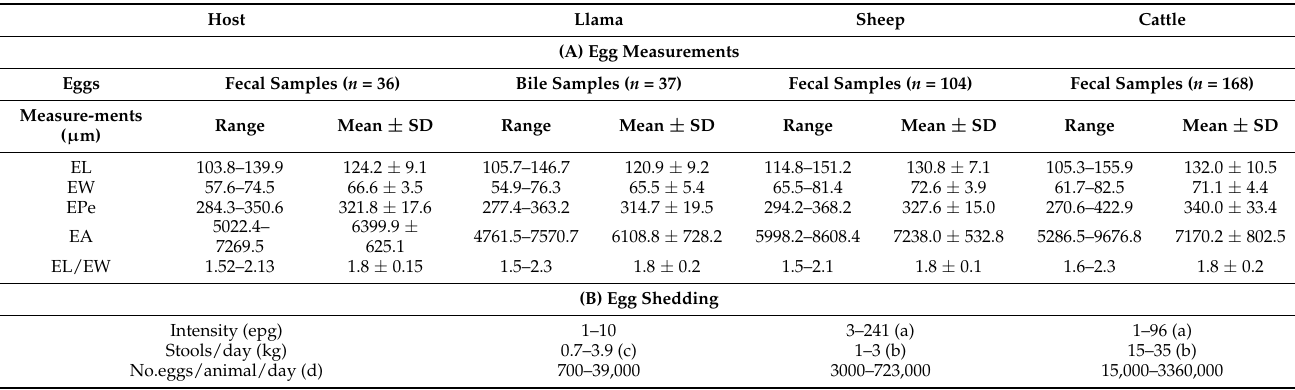
Table 3. Comparison of egg measurements ( A ) and egg shedding ( B ) between the Fasciola hepatica llama isolate from Argentina and the sheep and cattle isolates from the Northern Bolivian Altiplano human hyperendemic area. Host Llama Sheep Cattle (A) Egg Measurements Eggs Fecal Samples ( n = 36) Bile Samples ( n = 37) Fecal Samples ( n = 104) Fecal Samples ( n =